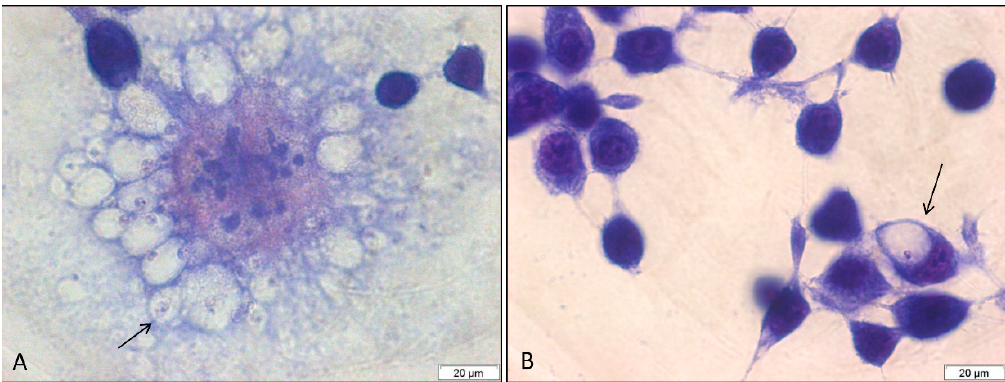
Figure 2. Light microscopy of Leishmania amazonensis intracellular amastigotes in J774.G8 macrophages. ( A ) L. amazonensis infected non-treated cells showing numerous internalized amastigotes (arrow). ( B ) L. amazonensis infected cells treated with 7.93 µg/mL of Endlicheria bracteolata essential oil against showing few amastigotes (arrow). Giemsa.